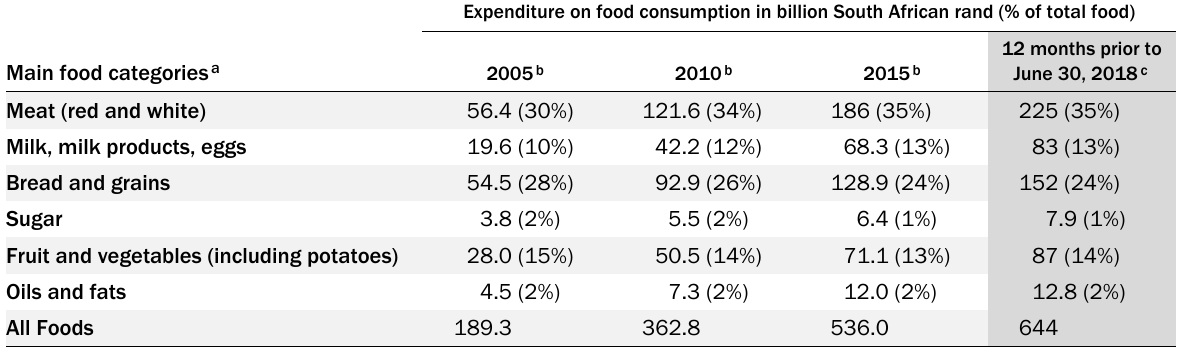
Table 1. Private Expenditure on Food by Main Food Categories, 2005, 2010, 2015, and